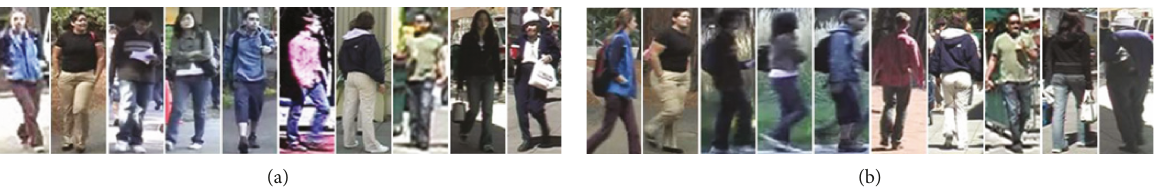
Figure 2: Image examples of the VIPeR dataset.